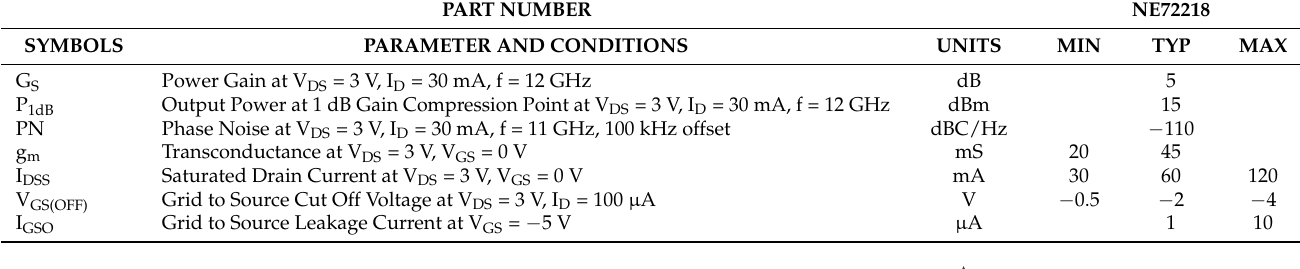
Table 1. Electrical characteristics of NE72218.